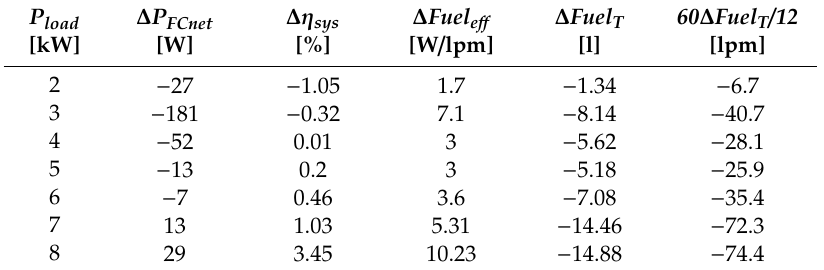
Table 3. The gaps in performance indicators for the Fuel-LFW and sFF strategies (P RES = 0). P load ∆ P